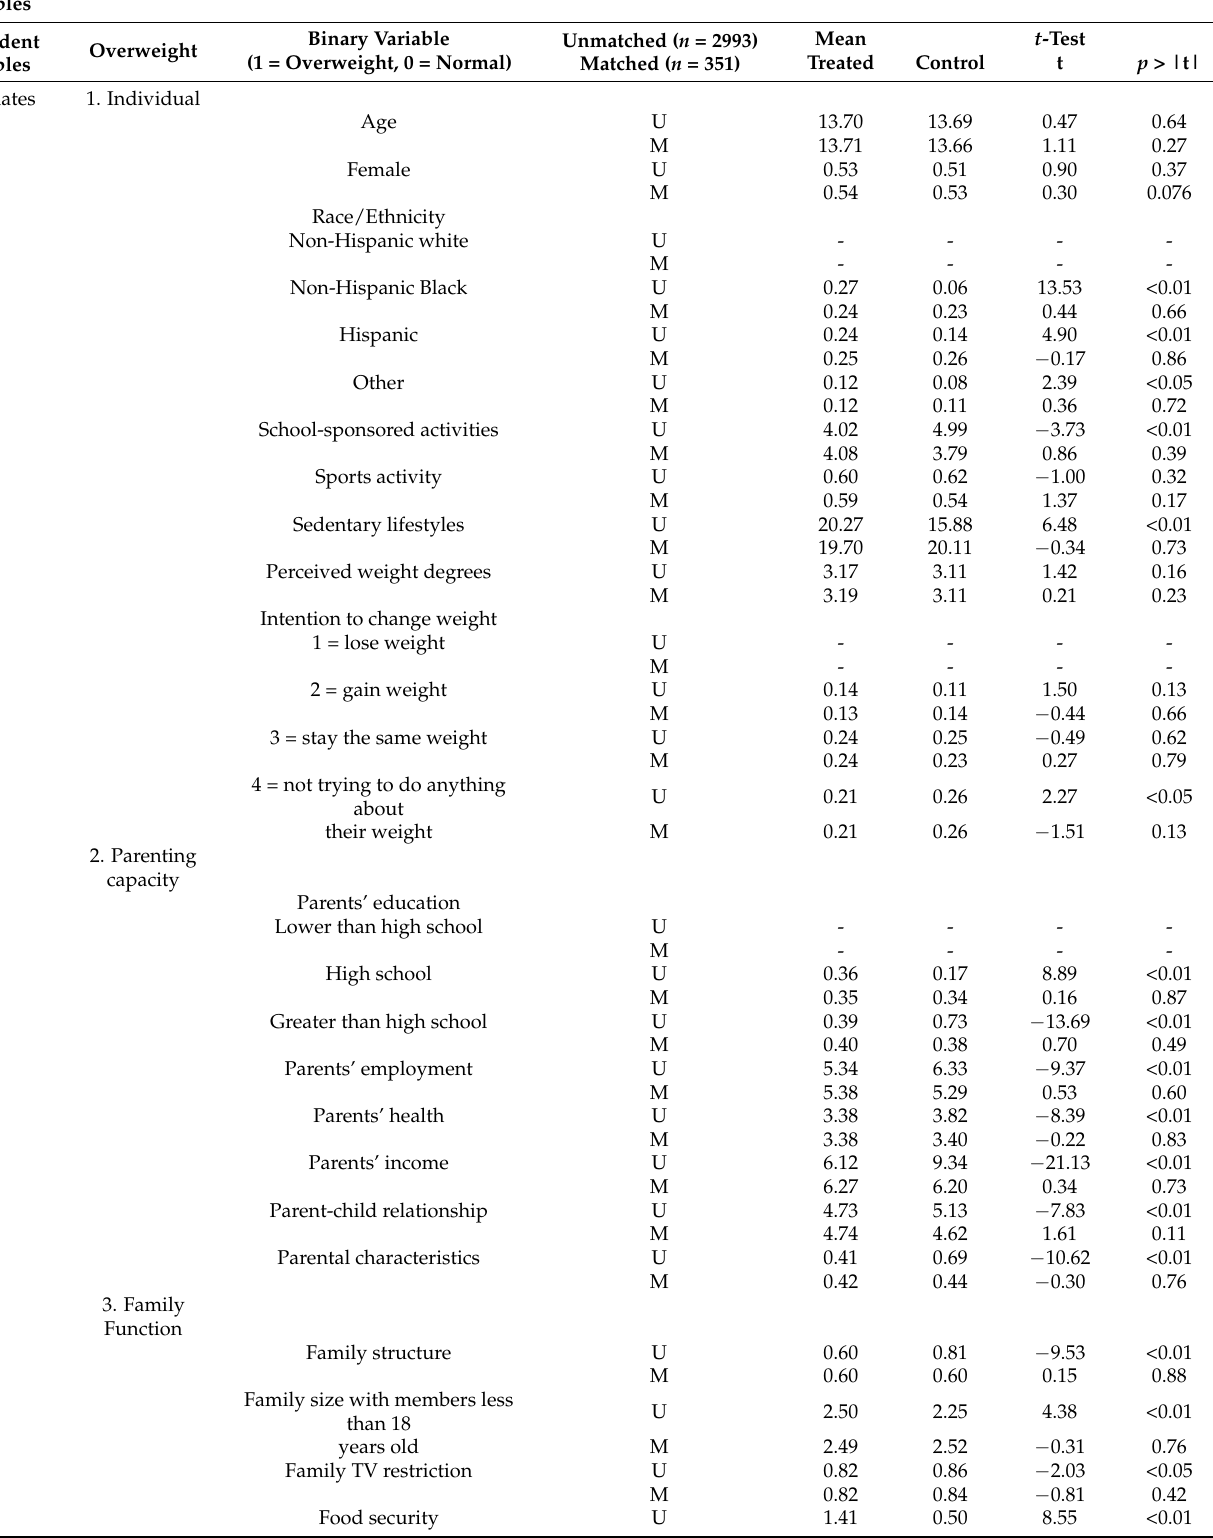
Table 3. PS test comparison between matched and unmatched